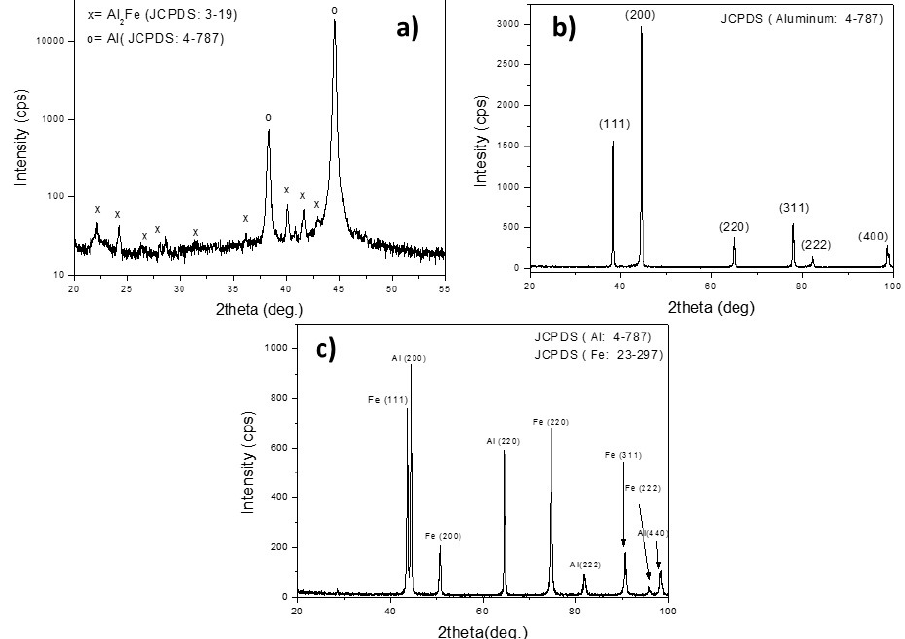
Figure 13. ( a ) Precision X-ray diffraction analysis in the thinner intermetallic layer. X-ray diffraction analysis in the ( b ) aluminum and ( c ) steel fusion zone.